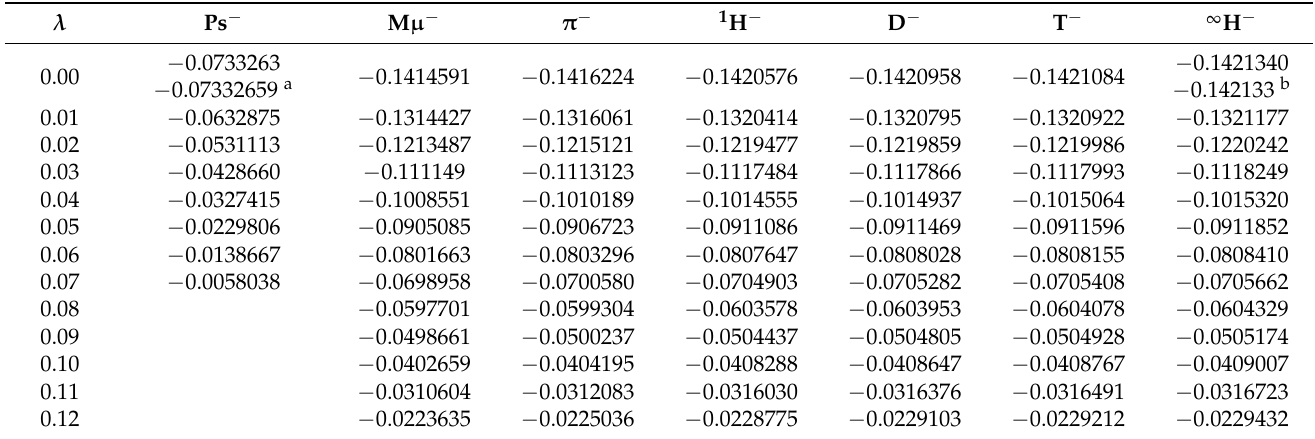
(cid:0) × (cid:1) 10 − 4 (a.u.) of hydrogen-like ionic systems for different values of